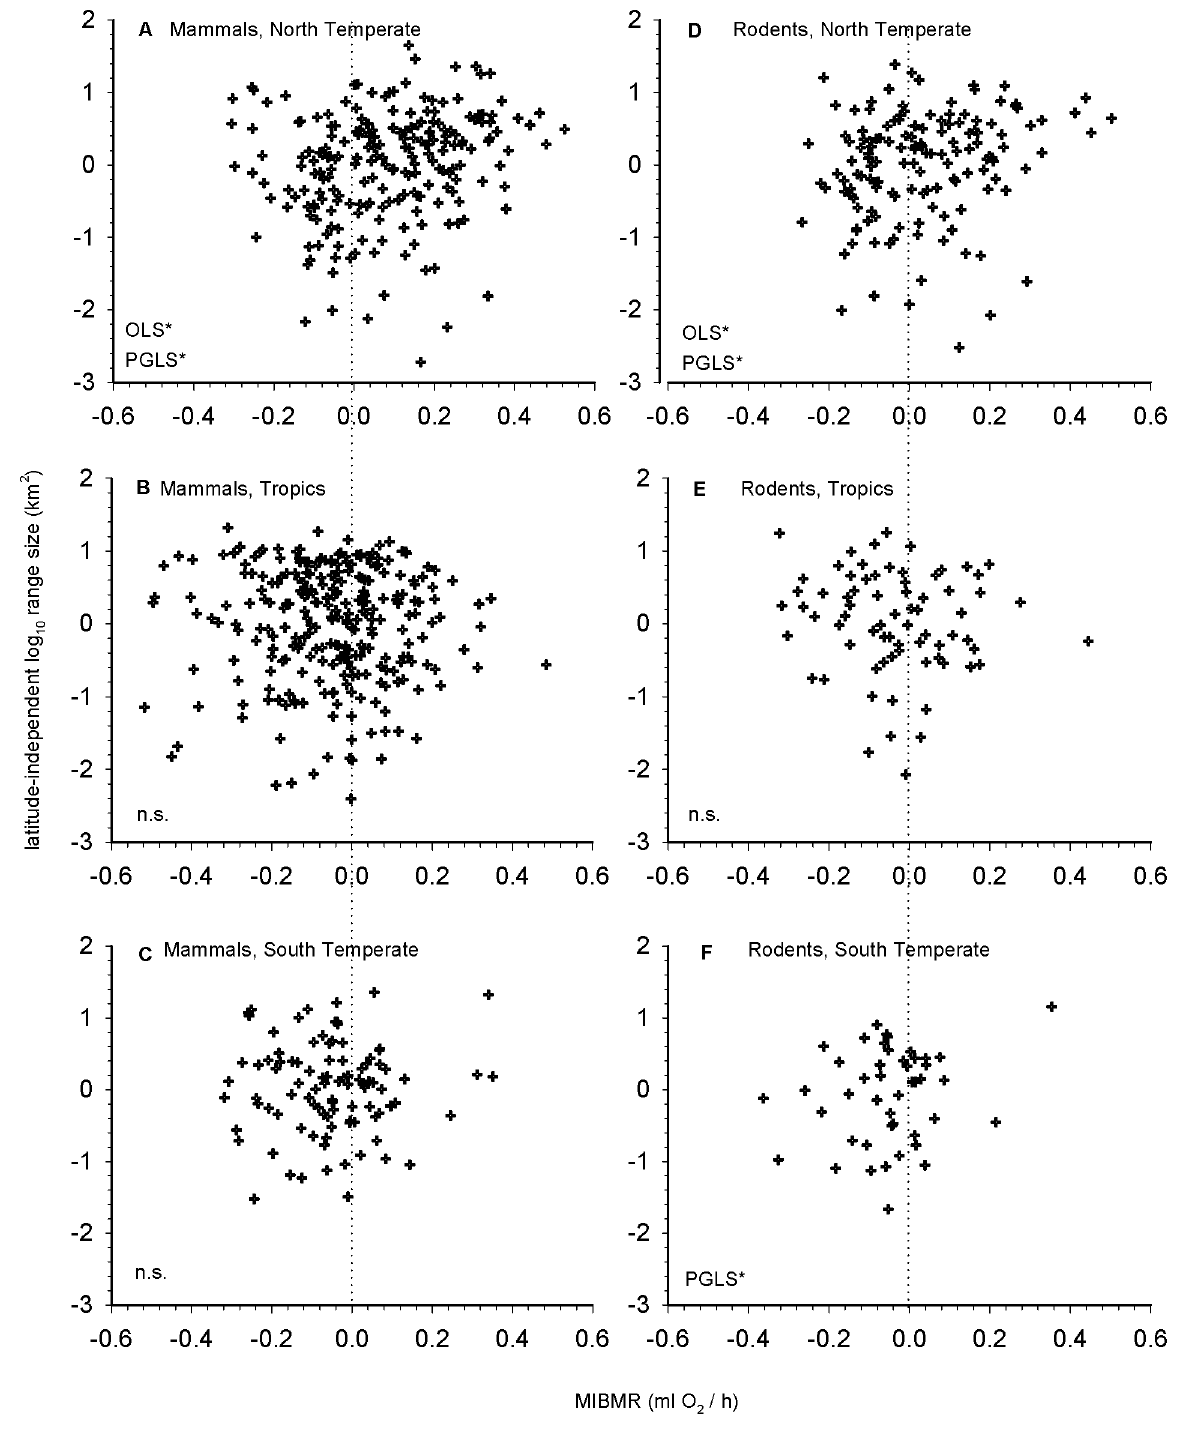
Figure 5. Among-species relationship between latitude-independent geographic range size and MIBMR for species whose range latitudinal midpoint occurs in the (a, d) North, (b, e) Tropics and (c, f) South for all mammals and rodents. Significant OLS and PGLS relationships are indicated by an asterisk.